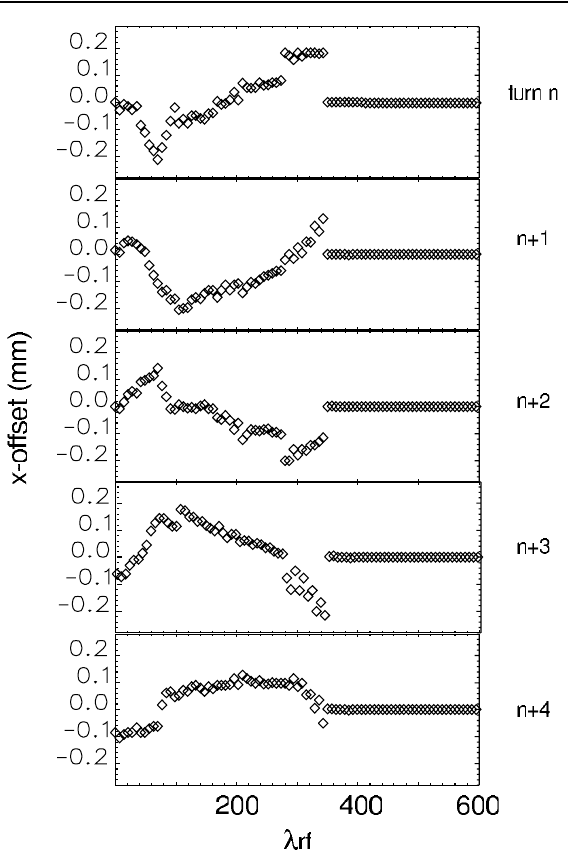
11.FIG. 12. Bunch-by-bunch horizontal centroid oscillations